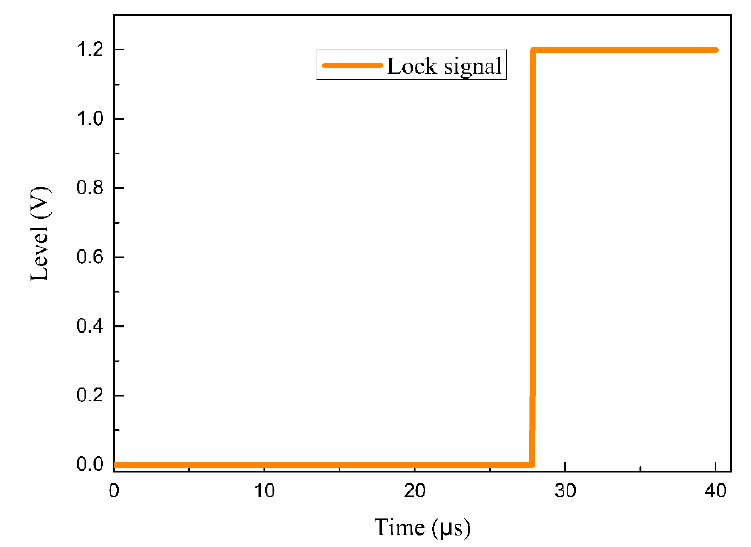
Figure 8. The lock signal with time.